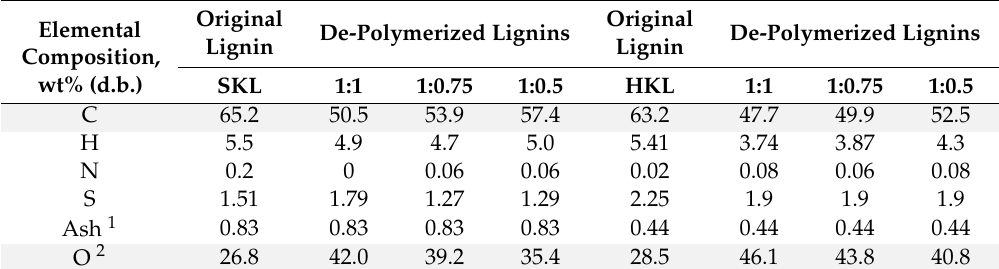
Table 2. Elemental compositions of the original SKL, HKL, and depolymerized lignin samples